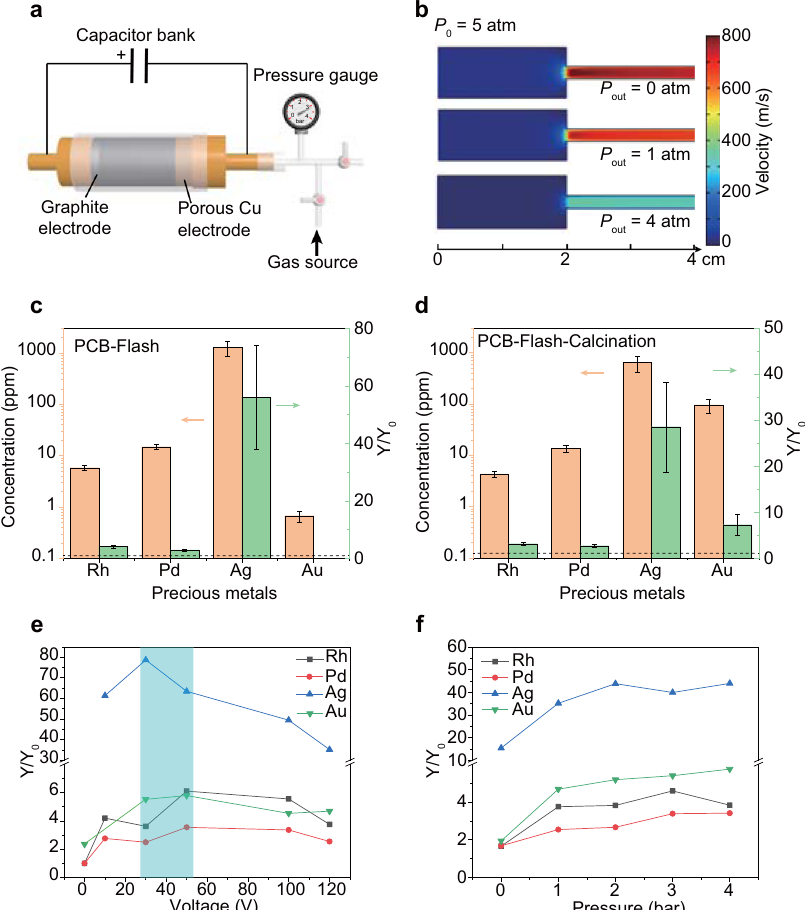
Fig. 3 Leaching ef fi ciency improvement of precious metals by the fl ash Joule heating (FJH) process. a Schematic of the pressurized setup for FJH. b Gas fl ow simulation under different pressures. The inner pressure ( P P 0 ) during the FJH was calculated to be ~5 atm. out of 0 atm, 1 atm, and 4 atm correspond to the FJH under vacuum, atmospheric pressure, and 3 atm of positive pressure. c Concentration of precious metals and improvement of recovery yield by FJH. Y 0 and Y mean the recovery yield by leaching printed circuit board (PCB) and PCB-Flash, respectively. The dashed line denotes Y/Y 0 = 1. The error bars denote the standard deviation where n = 3. d Concentration of precious metals and improvement of recovery yield by FJH and calcination. Y 0 and Y mean the recovery yield by leaching PCB and PCB-Flash-Calcination, respectively. The dashed line denotes Y/Y 0 = 1. The error bars denote the standard deviation where n = 3. e Improvement of recovery yield varied with FJH voltages under atmospheric pressure. The highlighted region is the approximate optimal voltage for all metal recovery. f Improvement of recovery yield varied with pressure. For e and f , the recovery yields of Rh, Pd, and Ag are calculated from PCB-Flash, and the recovery yield of Au is calculated from